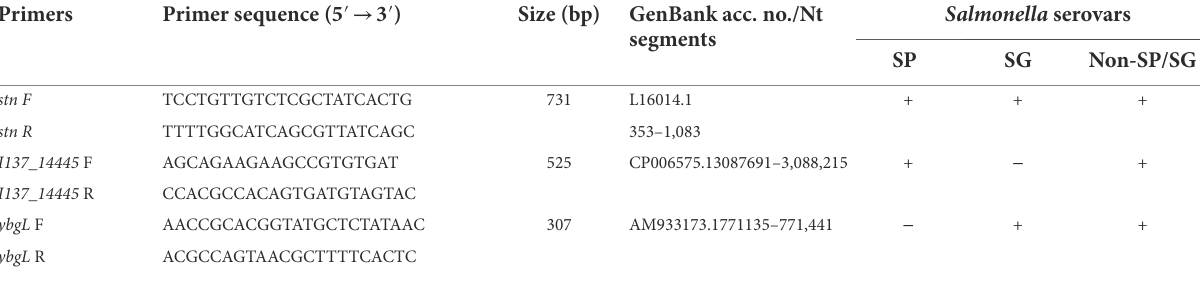
TABLE 1 Primer sequences for the specific detection and differentiation of S. gallinarum and S. pullorum with the multiplex PCR system.